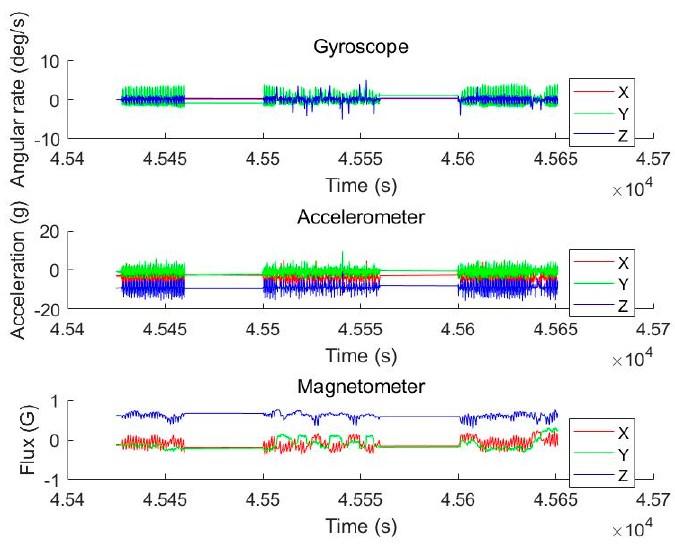
Figure 9. Primitive data obtained by INS devices.